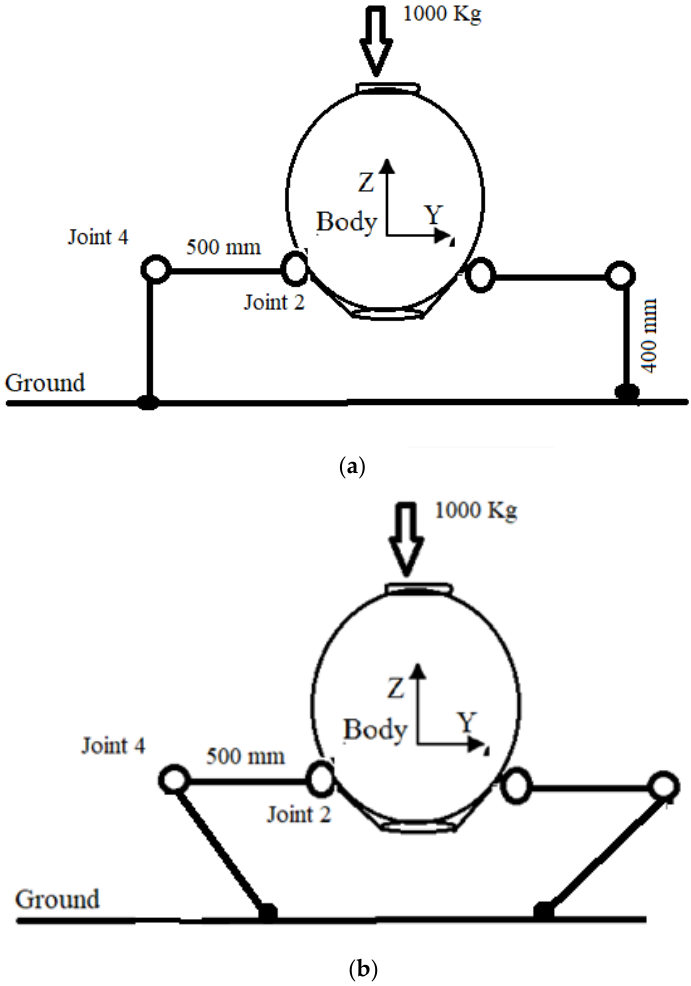
Figure 14. Extreme posture with the body supported by five legs, ( a ) payload joint 2, and ( b ) payload joint 4.